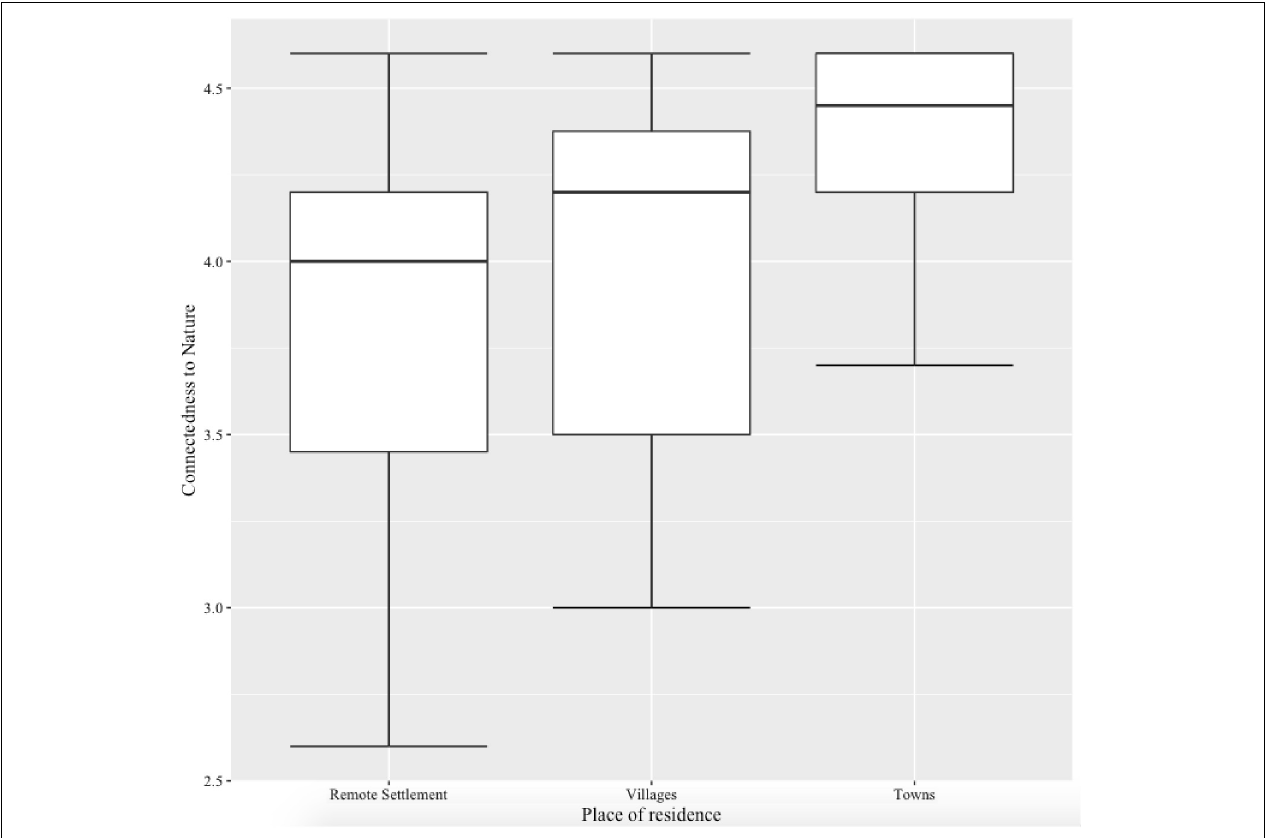
FIGURE 1 | Graphical representation of analysis of variance (ANOVA) with participants’ place of residence (independent variable) and emotional connectedness to nature score (dependent variable).